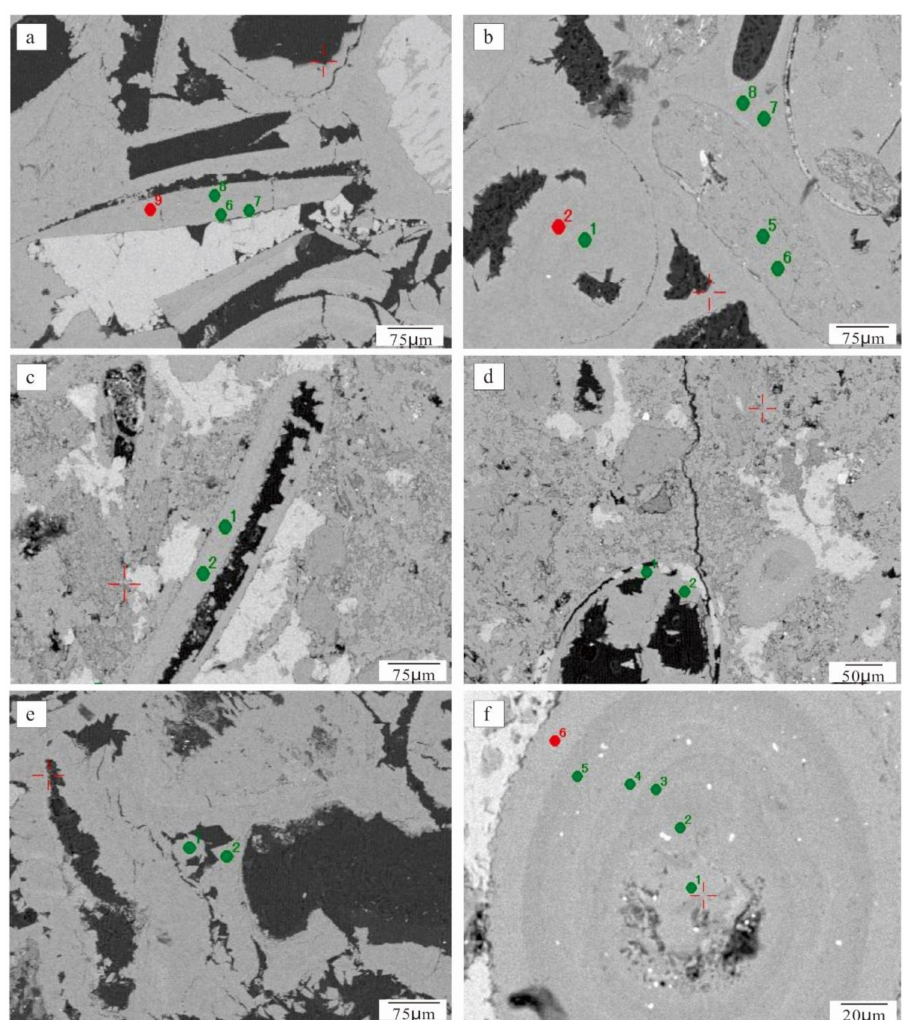
Figure 4. Optical backscattered electron microscope images of different types of dolomite: ( a ) microcrystalline coating dolomite (a-6, a-7) and crystalline dolomite on the inner wall of moldic pores (a-8, a-9); ( b ) pore-filling dolomite filling the moldic pores (b-1, b-2) and pore-lining dolomite developed around the residual intergranular primary pore (b-7, b-8); ( c ) microcrystalline coating dolomite wrapped around bioclastic grains (c-1, c-2); ( d ) crystalline dolomite on the inner wall of moldic pores (d-1); ( e ) pore-filling dolomite filling the residual intergranular primary pores (e-1) and pore-lining dolomite developed around the pore (e-2); ( f ) various cortical laminae of oolites (see analytical data in Table